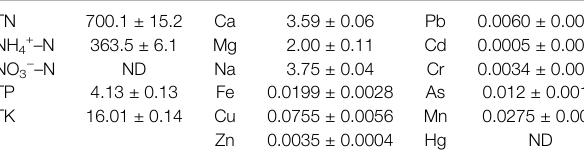
TABLE 1 | The basic properties of biogas residues from pig biogas plant Unit: